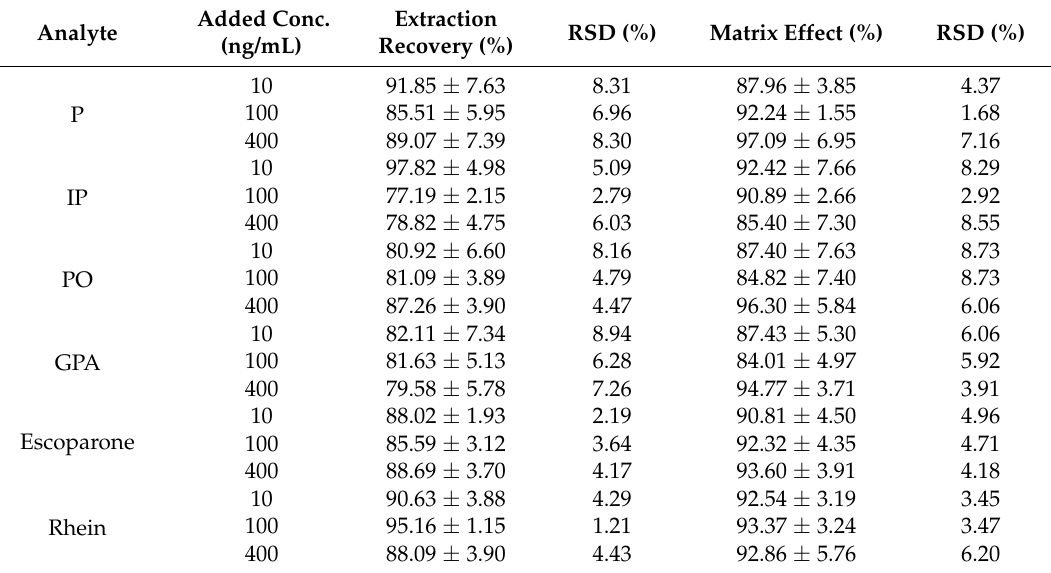
Table 2. Recovery and matrix effect of analytes and